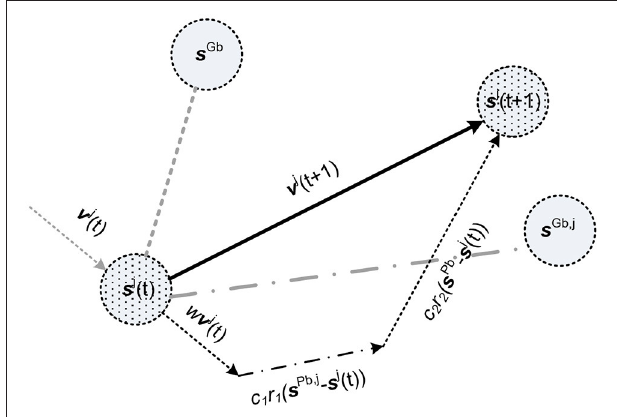
FIGURE 2 | Graphic description of particle’s positioning indicatively for the 2D design